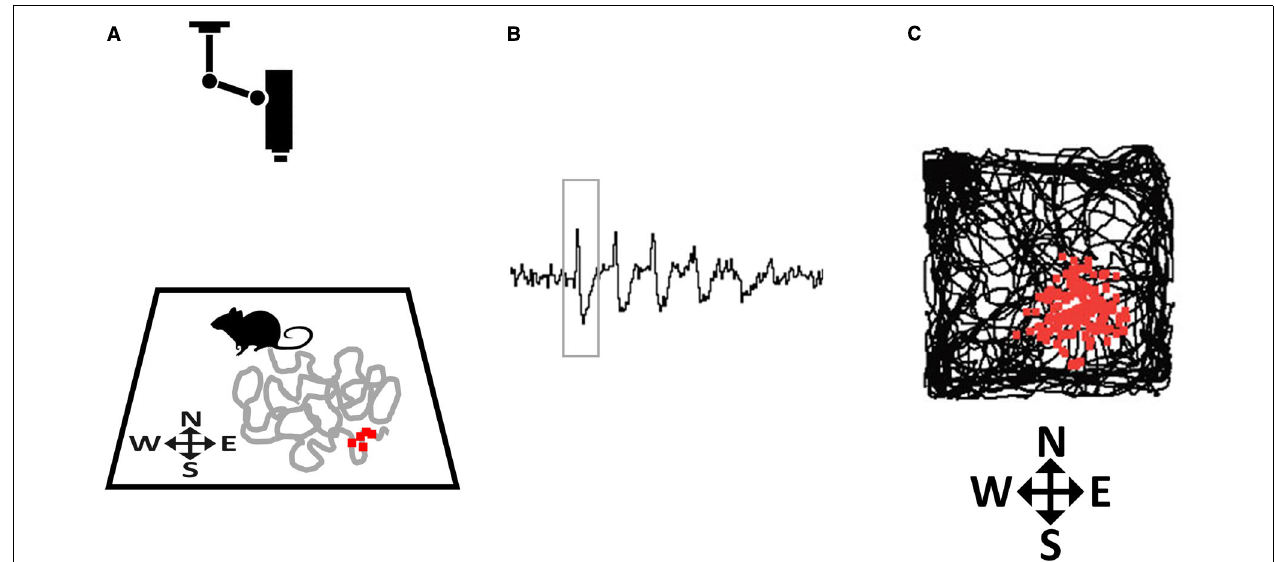
FIGURE 2 | How place fields are recorded. (A) A rat explores a small environment (in this case, a square arena) while being tracked by an overhead camera. The gray line tracks the recent path of the rat and the small red squares depict action potentials (spikes) emitted by a hippocampal neuron that was recorded from implanted microelectrodes, plotted at the point where they